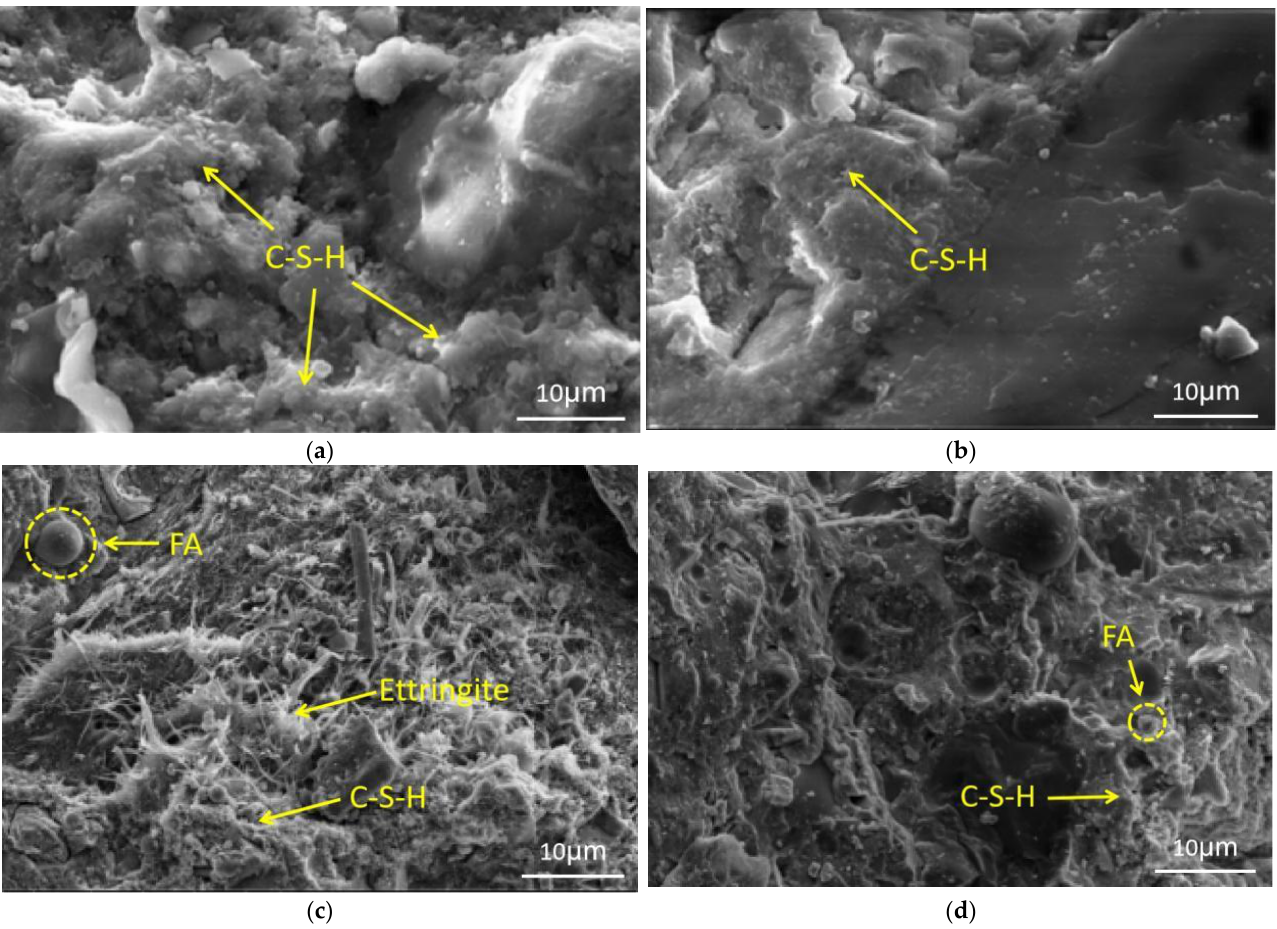
Figure 8. SEM images of EUHPC under standard curing and steam curing: ( a ) S20F0G20 under standard curing; ( b ) S20F0G20 under steam curing; ( c ) S15F15G15 under standard curing; ( d ) S15F15G15 under steam curing.